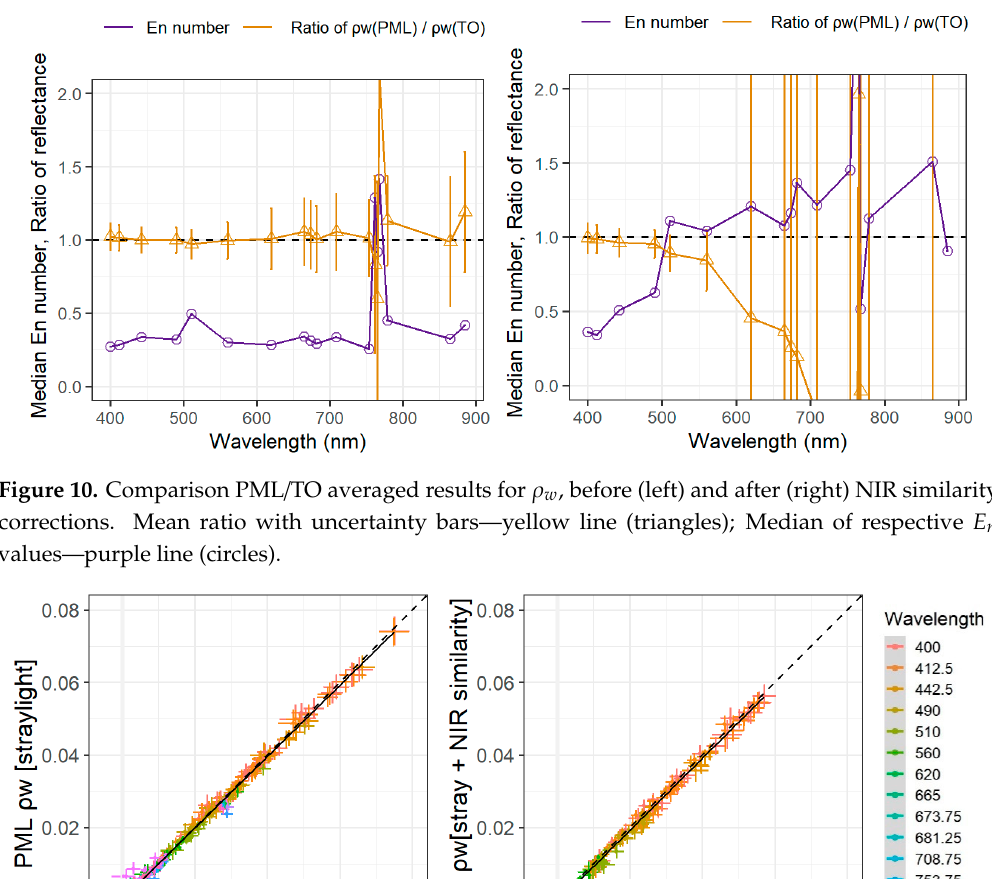
(cid:2914) between TO and PML (triangles) and agreement between the results from two radiometric systems, expressed as median E n number of the ratio (circles) over all stations.